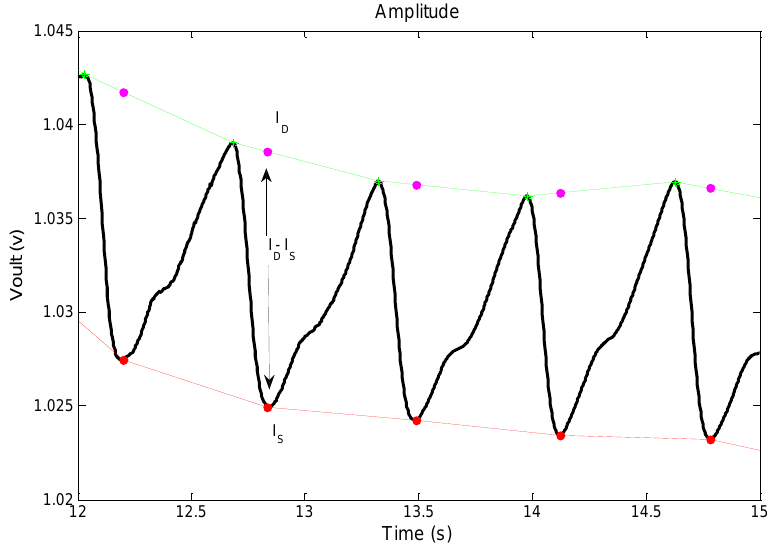
, and the determination of the pulse amplitude as D and the measured value of I D